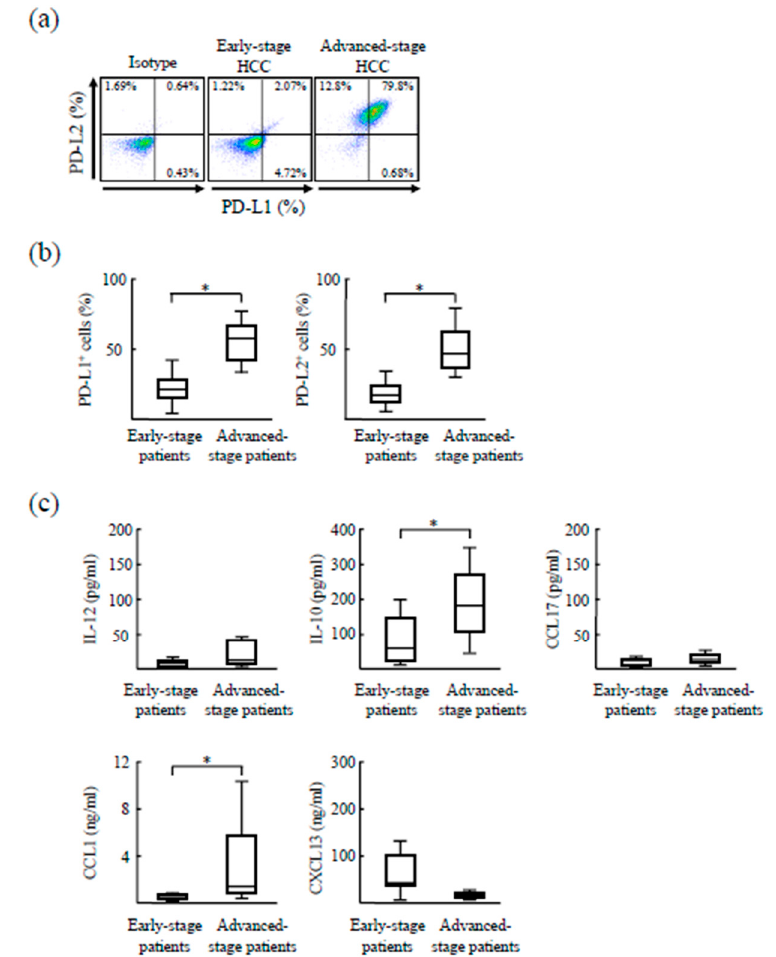
Figure 2. Differences in the properties of CD14 + cells in the same patients at early and advanced HCC stages. ( a , b ) CD14 + cells were isolated from HCC patients ( n = 12) at early tumor stages before initial treatment and at advanced stages after treatment initiation. These cells were stained with anti-PD-L1 and anti-PD-L2 antibodies and assayed by flow cytometry. ( c ) CD14 + cells were cultured for 24 h, and the culture media was assayed by ELISA for IL-12, IL-10, CCL17, CCL1, and CXCL13 production. * p < 0.05. PD-L, programmed death ligand.